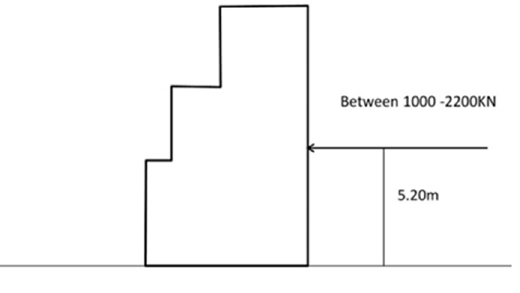
Figure 4. Load state B.